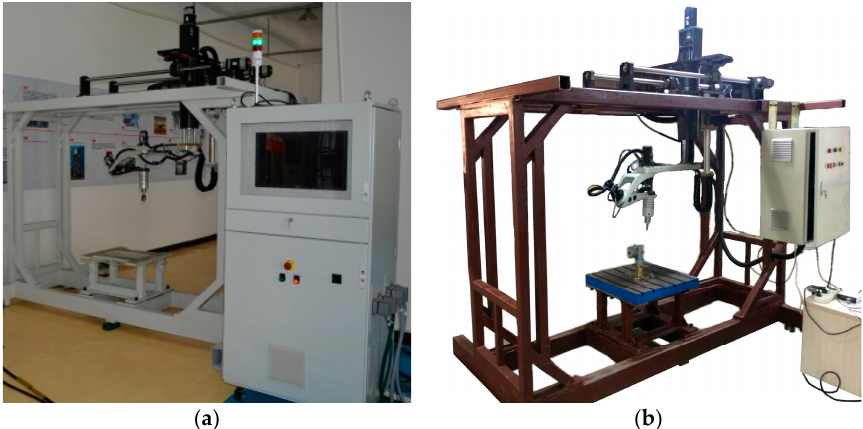
Figure 2. Experimental platforms of robot manipulator: ( a ) original platform; ( b ) improved platform.